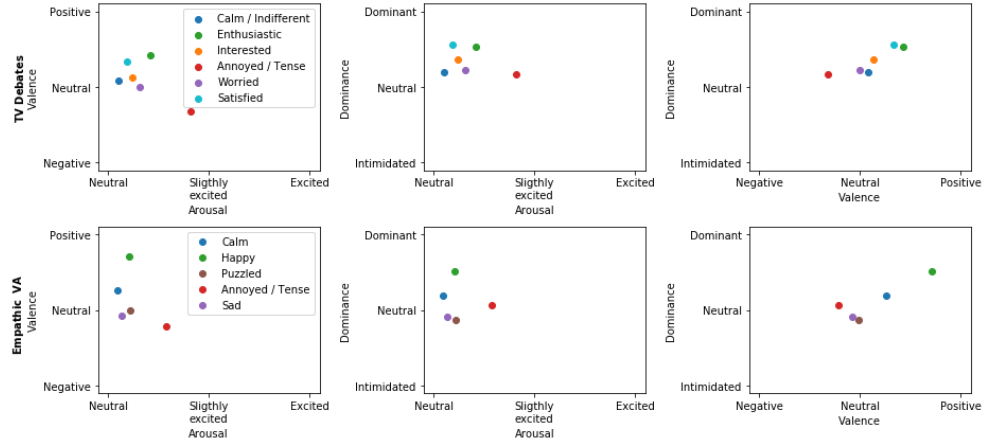
Figure 7. Representation of the mean value of each of the categories in the dimensional model.